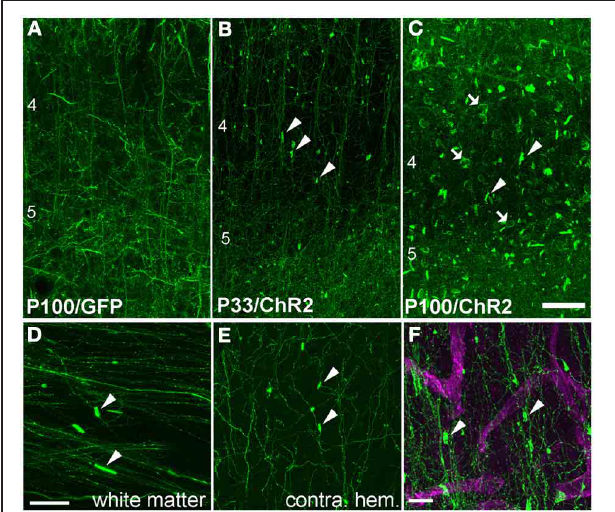
FIGURE 3 | Axonal swellings on ChR2 + axons. (A) Morphologically normal L2/3 pyramidal cell axons in L4 and L5 of electroporated S1, from a P100 rat electroporated with GFP only. (B–C) ChR2 + axons in L4 and L5 of two ChR2-electroporated rats, at P33 and P100. Arrowheads, cylindrical axonal swellings. Arrows, calyceal structures. (D–E) Axonal swellings in white matter underlying electroporated S1, and in callosal S1 axons in contralateral (non-electroporated) S1. (F) Dual fluorescent staining of ChR + axons in L4 and the capillary marker collagen IV (magenta). Scale bar in (A–E) , 50 μ m. Scale bar in (F) , 10 μ